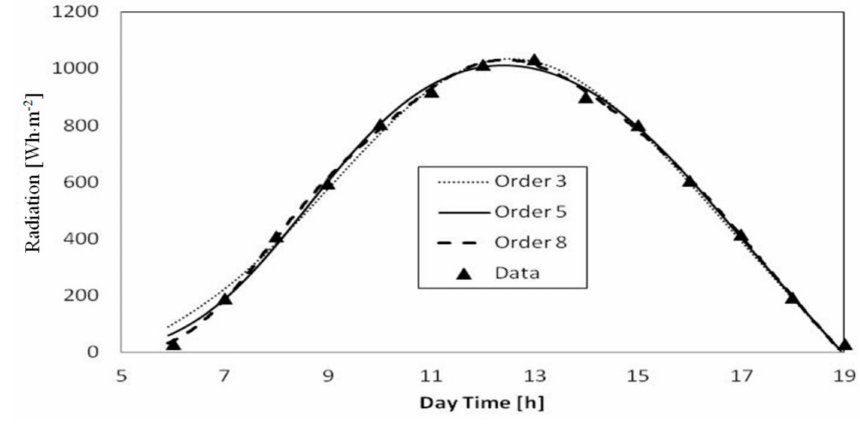
Figure 4. Simulated global radiation at di ff erent orders of the Fourier series in Perth.